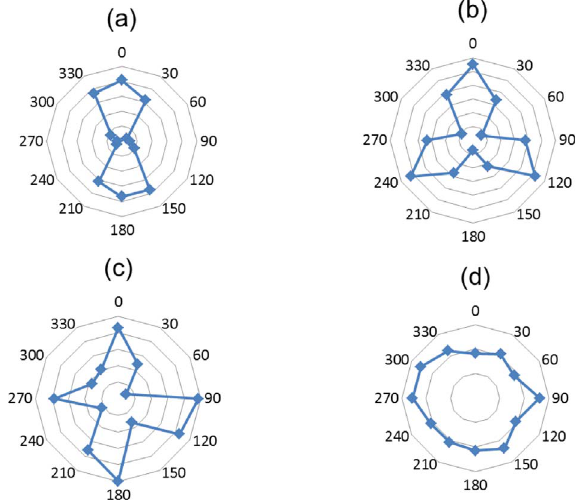
Figure 7. Experimental mode shapes of Coil55: (2,0) at 126 Hz (a), (3,0) at 355 Hz (b), at 667 Hz (4,0) (c) and (0,0) at 2455 Hz